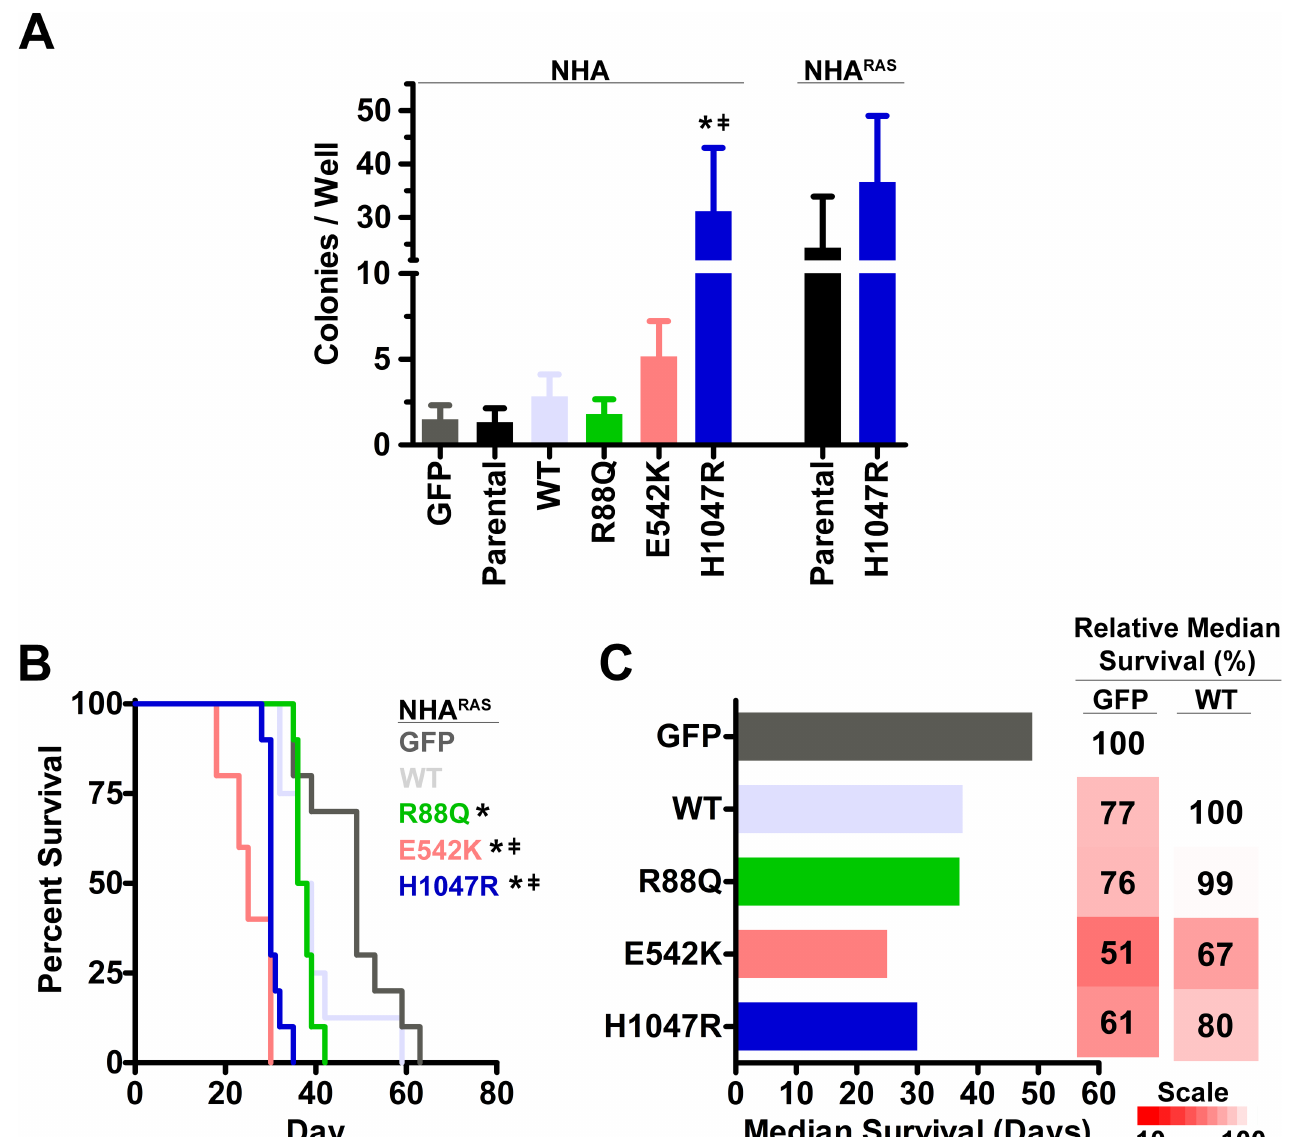
Fig 3. Helical and kinase PIK3CA mut potentiate cellular transformation and tumorigenesis. Only H1047R increased colony formation compared to parental ( (cid:3) , P = 0.03) and PIKCA WT (‡, P = 0.04) NHA ( A ). H1047R did not affect colony formation of NHA RAS (P = 0.5). Orthotopic xenografts of GFP, PIK3CA WT , and PIK3CA mut NHA RAS ( BC ). Median survival of mice with R88Q, E542K, or H1047R PIK3CA mut NHA RAS was decreased compared to GFP control tumors ( (cid:3) , P (cid:20) 0.003). E542K and H1047R PIK3CA mut also decreased survival compared to PIK3CA WT (‡, P (cid:20) 0.002) and R88Q PIK3CA mut (P < 0.0001). Fold changes in median survival relative to GFP and PIK3CA WT NHA RAS are shown as